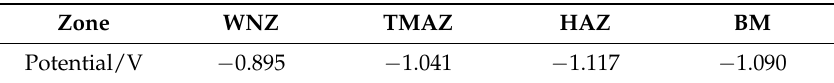
Figure 13. The polarization curves of different areas of the transverse section of keyhole-free FSSW joints in 3.5% NaCl solution. Table 2. The self-corrosion potentials of different areas of the transverse section of keyhole-free FSSW joints.